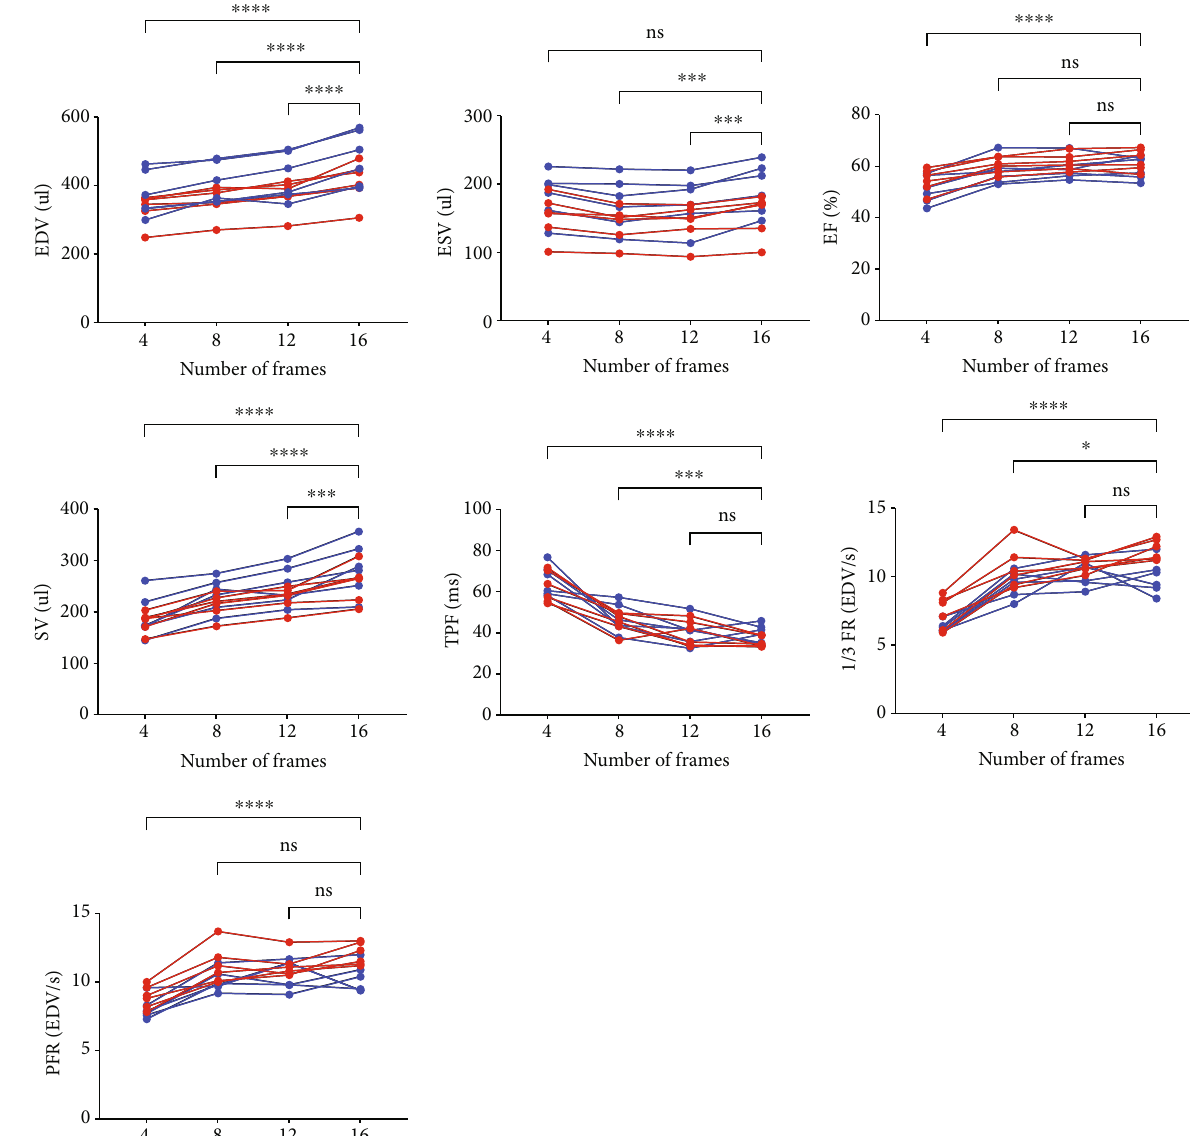
Figure 4: Comparison of the LV volumes and functional parameters of all animals ( ZDF diabeticanimal = blue , ZL controls = red ) with di ff erent numbers of frames per cardiac cycle using Holm-Sidak ’ s multiple comparison test with 16 frame data as reference. The LV volumes (EDV, ESV, and SV) of the 4, 8, and 12 frame data di ff er signi fi cantly from the reference, whereas for EF and diastolic parameters (TPF, 1/3 FR, and PFR), no signi fi cant di ff erence between the reconstruction with 12 gates per cycle and the reference was recorded. EDV: end-diastolic volume; ESV: end-systolic volume; SV: stroke volume; EF: ejection fraction; TPF: time to peak fi lling;